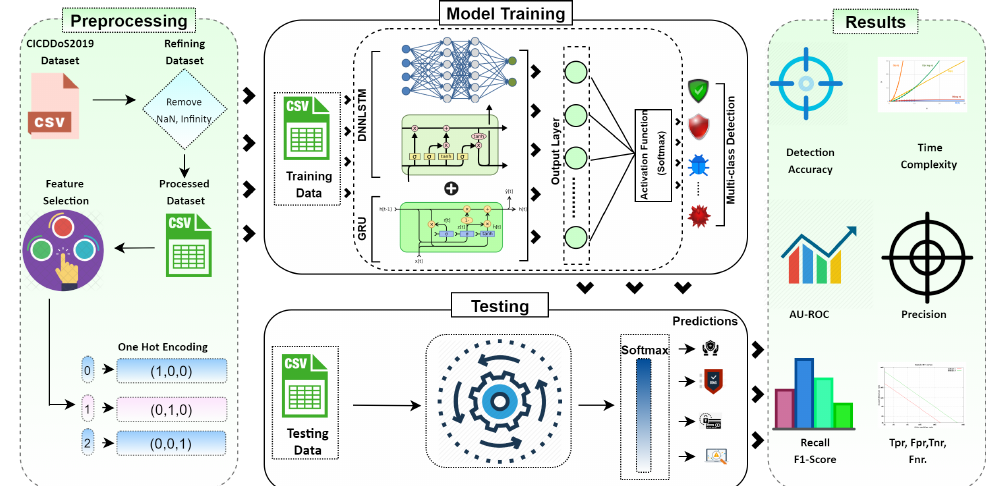
Figure 2. DL-driven SDN-enabled